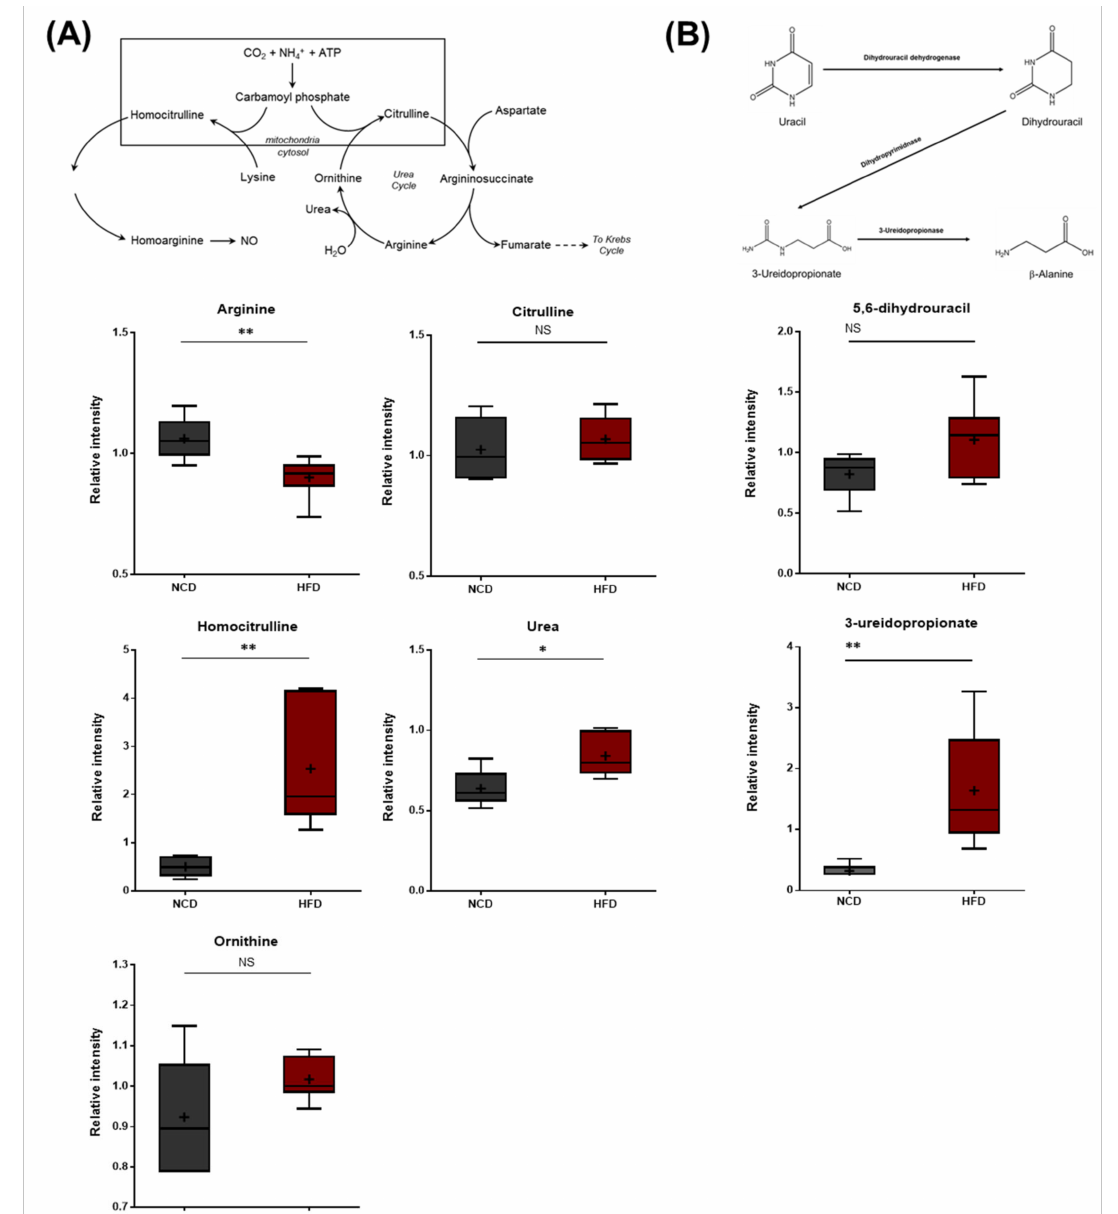
Figure 9. Pathway of statistically significant biochemicals profiled between NCD group and HFD group. Metabolites in ( A ) arginine metabolism, urea cycle pathway, and ( B ) uracil catabolism were altered in the HFD group. Urea was found at an elevated level via homocitrulline. Also, the HFD group exhibited elevated levels of uracil catabolism. Data were presented as mean ± SD ( n = 6) and two-way ANOVA with Bonferroni’s multiple comparison test * p < 0.05; ** p <